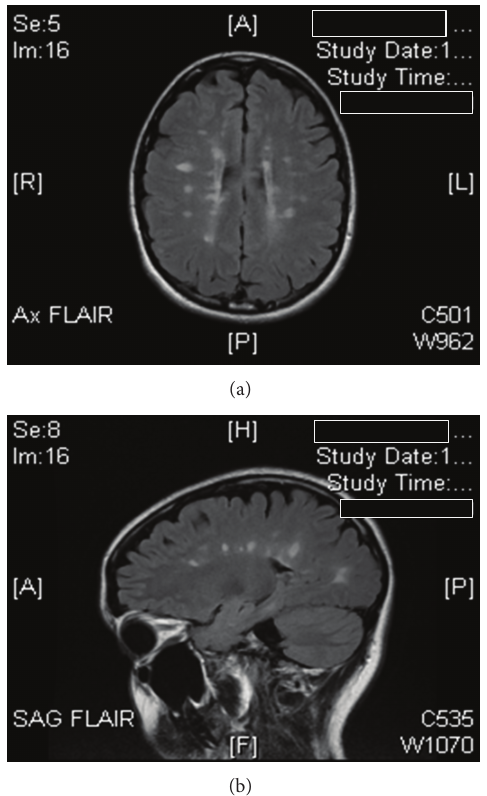
F 1: R: imaging demonstrates periventricular high signal intensity lesions, which exhibit a typical distribution for multiple sclerosis (Dawson�s �ngers). A: it shows corpus callosal hyperinten- sities suggestive of a demyelinating process. Patient does not have evidence of brain stem sagging, dilatation of vein or dural sinuses, and effacement of hemispheric cortical sulci. Absence of any of these signs does not preclude the diagnosis of postdural puncture